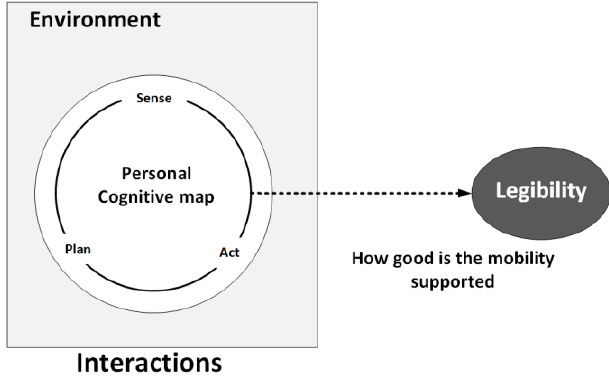
Figure 2. Relation of legibility and human–environment interactions.